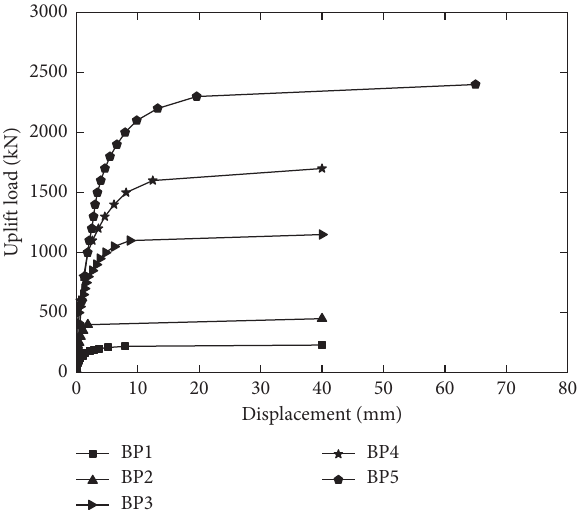
Figure 4: The uplift load-displacement curves for BP1 to BP5.